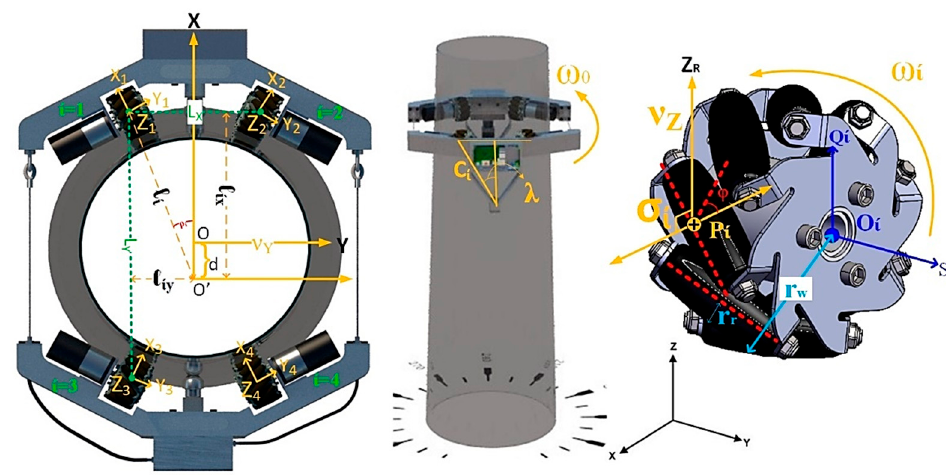
Figure 5. Coordinate System of WT Climbing Robot